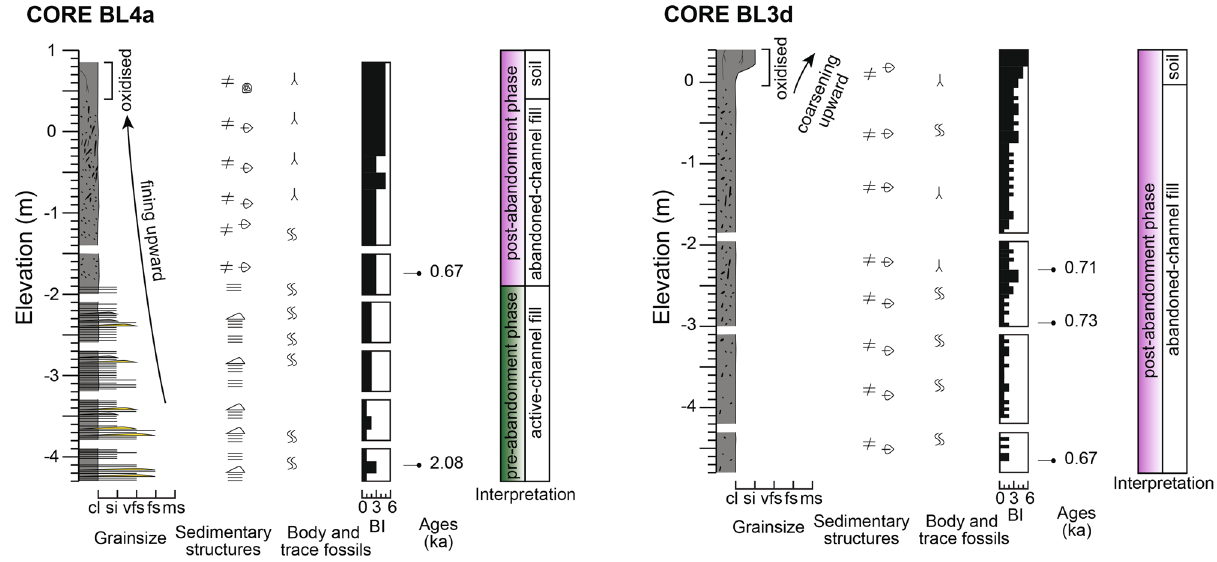
Figure 3. Sedimentological logs of the cores BL4a and BL3d with information about sedimentary features, trace and body fossils, ages and interpretations. Grain-size scale: cl = clay; si = silt; vfs = very-fine sand; fs = fine sand; ms = medium sand. See Fig. 2 for legend.